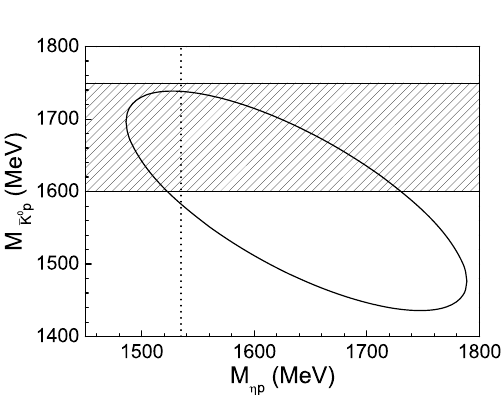
→ ¯ K 0 η p Figure 6. Dalitz plot for M η p and M ¯ c The N ∗ (1535) energy is shown by the vertical dotted line, which the horizontal band represents the masses of Σ ∗ states from 1600 to 1800 MeV.